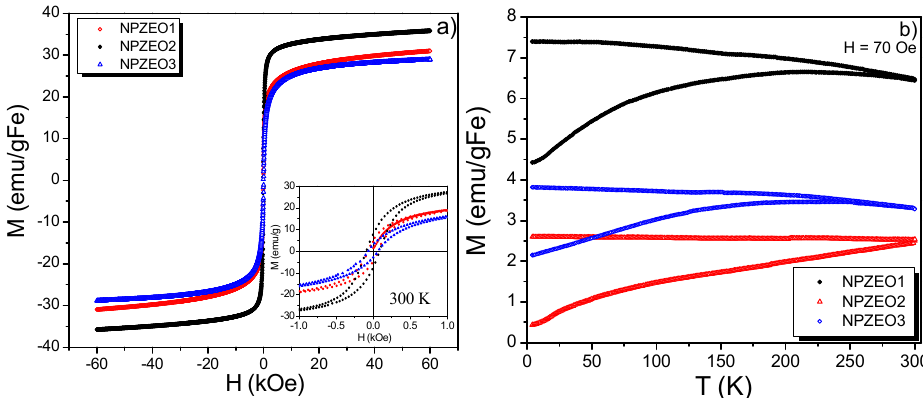
Figure 5. M-H loops recorded at 300 K ( a ) and zero field cooling (ZFC) and field cooling (FC) measurements ( b ) for NPZEO1, NPZEO2, and NPZEO3 samples. The inset in ( a ) is a magnification of the M-H loop in the region −1 to +1 kOe.